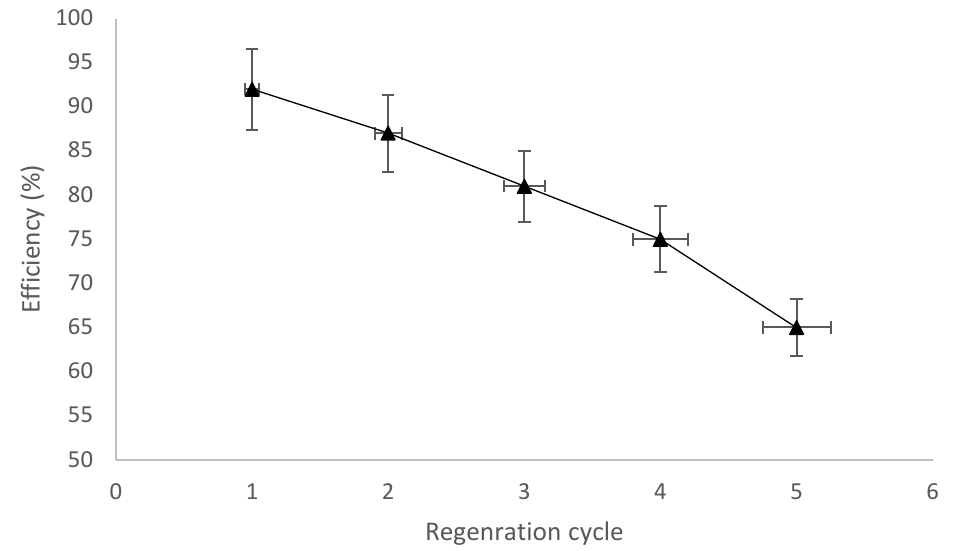
Figure 9. Decrease in percent efficiency of Cr(VI) removal for 5 consecutive cycle. Table 5. Biosorption capacity comparison of CMPVL with the